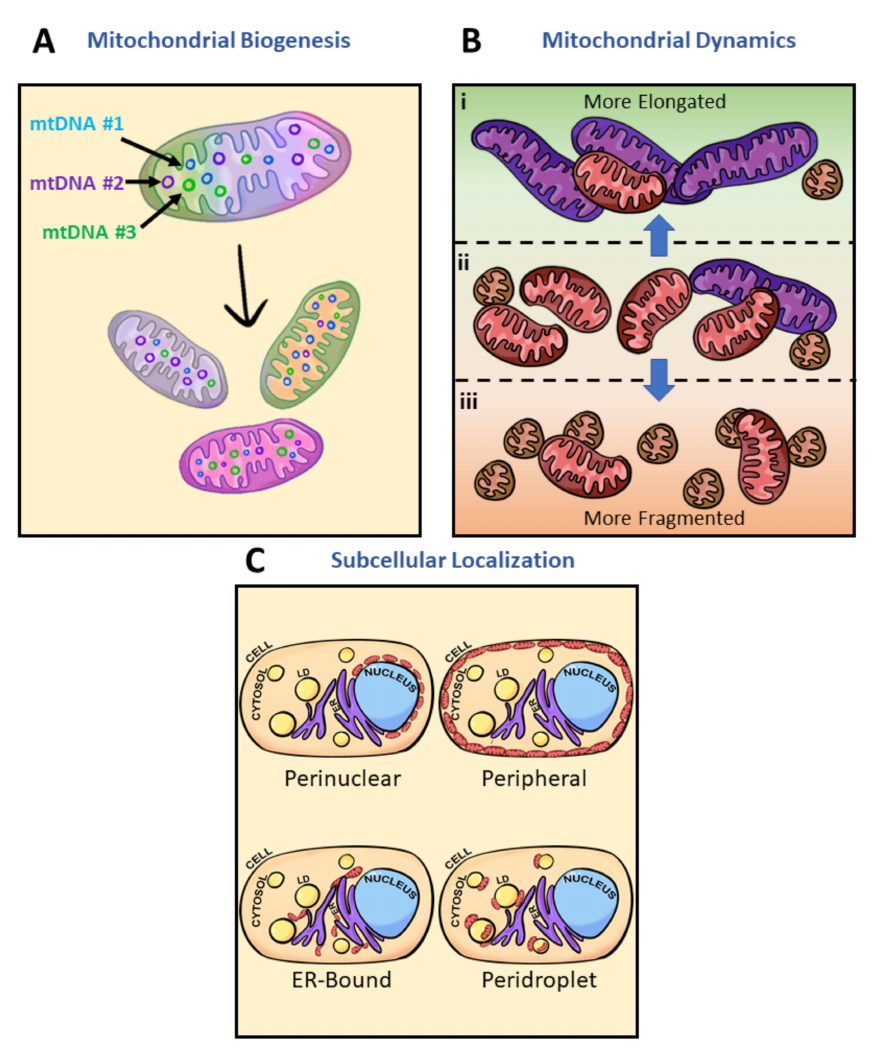
Figure 4. Inducers of mitochondrial heterogeneity. Potential sources of mitochondrial heterogeneity include mitochondrial biogenesis, architectural adaptation, and subcellular localization. ( A ) Mitochondrial biogenesis produces new mitochondria from preexisting ones (tricolor mitochondria); mitochondria which may have mtDNA sequence variation, and can induce variation in mitochondrial protein content or expression. Variations in mtDNA and copy number are represented by the circles of various colors within the mitochondria. Every single color (purple, blue, and green) depicted represents one version of mtDNA or expression pattern. As new mitochondria are made, the content within the new mitochondria will often not be perfect copies of the original mitochondria. Each different daughter mitochondria are of a different singular color to emphasize the dominance of one mtDNA. ( B ) Mitochondrial architectural adaptation often occurs in response to changes in environmental factors such as nutrient levels, oxidative stress, growth hormones, cell signaling, or pathogenicity. Mitochondria at basal state (ii) consist primarily of intermediate-sized mitochondria (red). The highly dynamic organelle has been observed to (i) elongate (purple) much of its population under starvation and (iii) fragment (orange) under nutrient excess. Adaptive mechanisms leading to changes in mitochondrial architecture thereby induce heterogeneity. ( C ) Mitochondrial localization within a single cell and unique traits associated with those regions represent another way heterogeneity is present in physiological states. Mitochondrial heterogeneity and metabolic flexibility are a product of the dramatic differences in mitochondrial phenotypes due to their cellular positions. Perinuclear mitochondria localize near the nucleus, peripheral mitochondria border the plasma membrane, ER-bound mitochondria are tethered to the ER, and peridroplet mitochondria are attached to lipid droplets. Diagram of a typical cell containing nuclei (blue), lipid droplets (LD) (yellow), endoplasmic reticulum (ER) (purple), cytoplasm (peach), and mitochondria (red ovals). For further discussion, see Figure